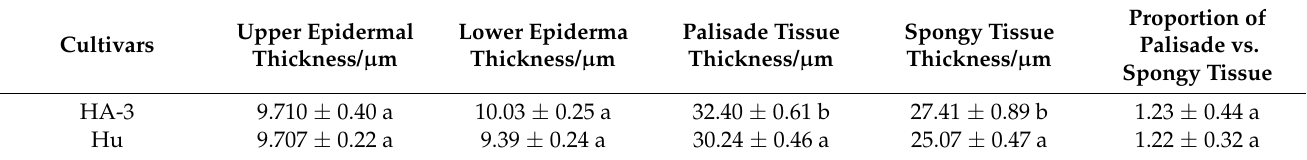
Table 1. Comparison of stem anatomical structures between HA-3 and Hu.